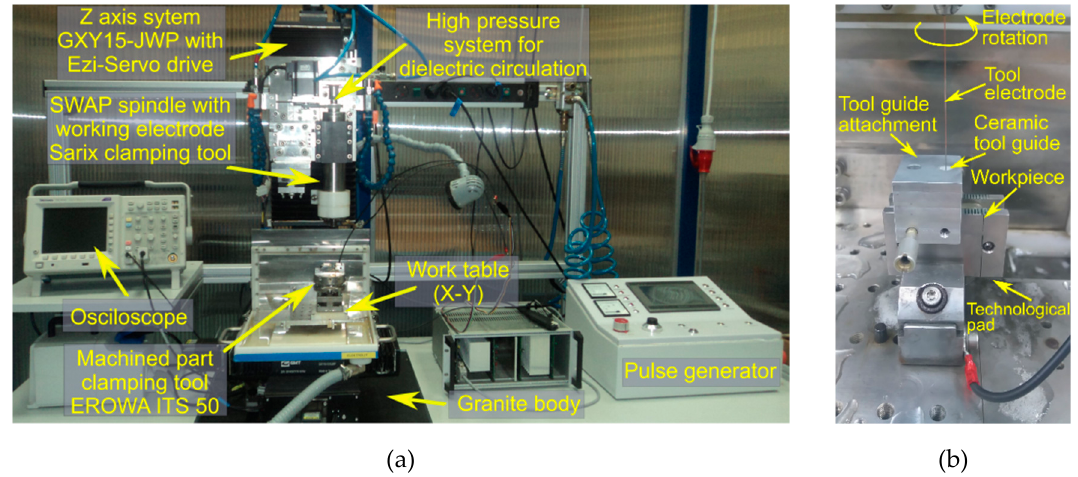
Figure 2. ( a ) Photograph of the test stand and ( b ) the experimental setup of the electrode guiding system. Table 3. Machining parameters.